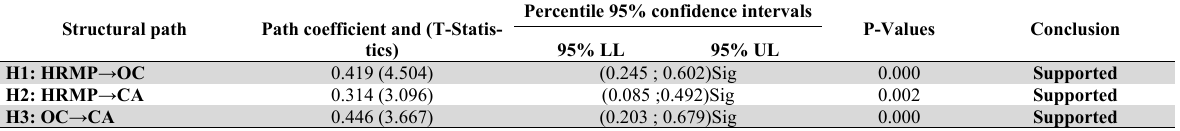
Assessment of path coefficients (direct relationship) Structural